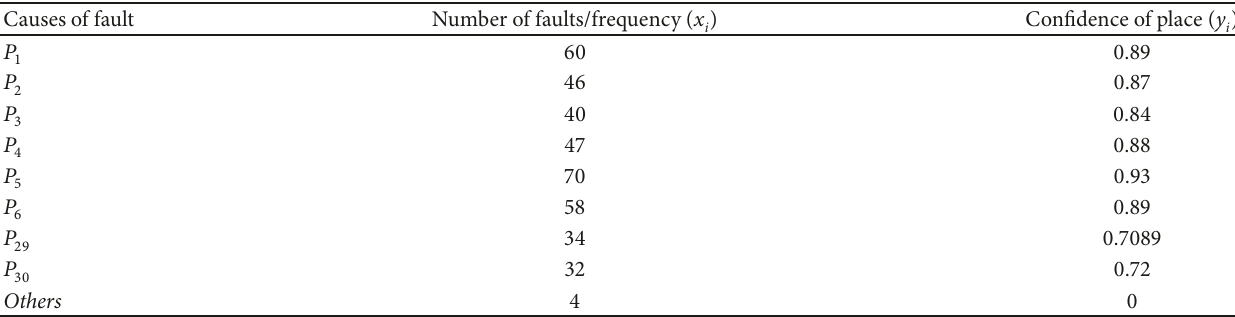
Table 1: Fault-related data.